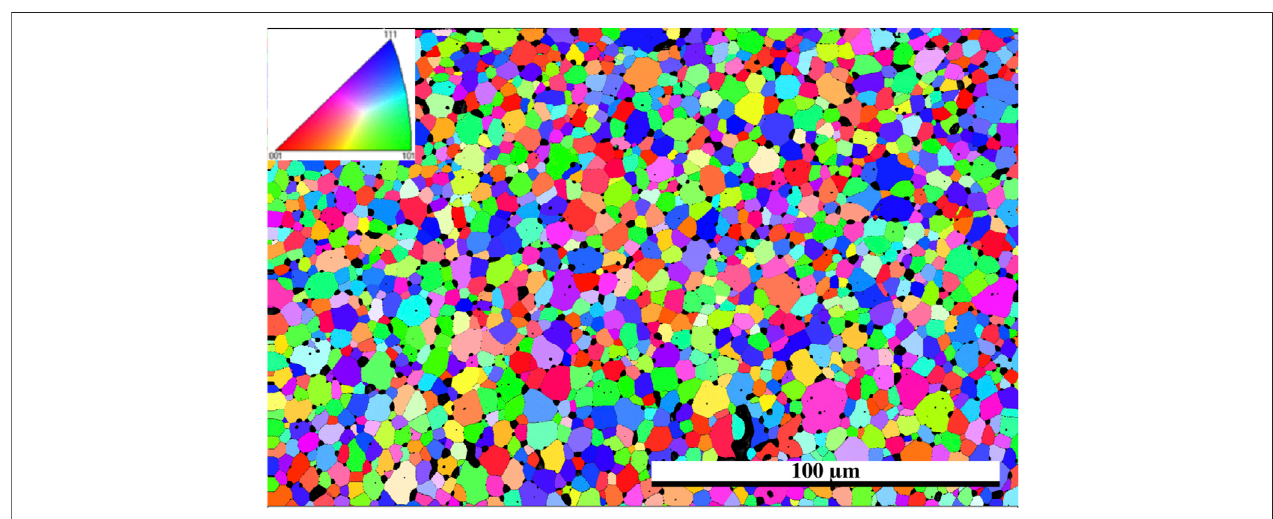
FIGURE 4 | EBSD grain orientation map ofEr 2 Ti 2 O 7 utilizing cif generated from neutron diffraction of the unirradiated specimen, direction of He 2+ ions are from the bottom of the image, inset shows pole fi gure orientation.